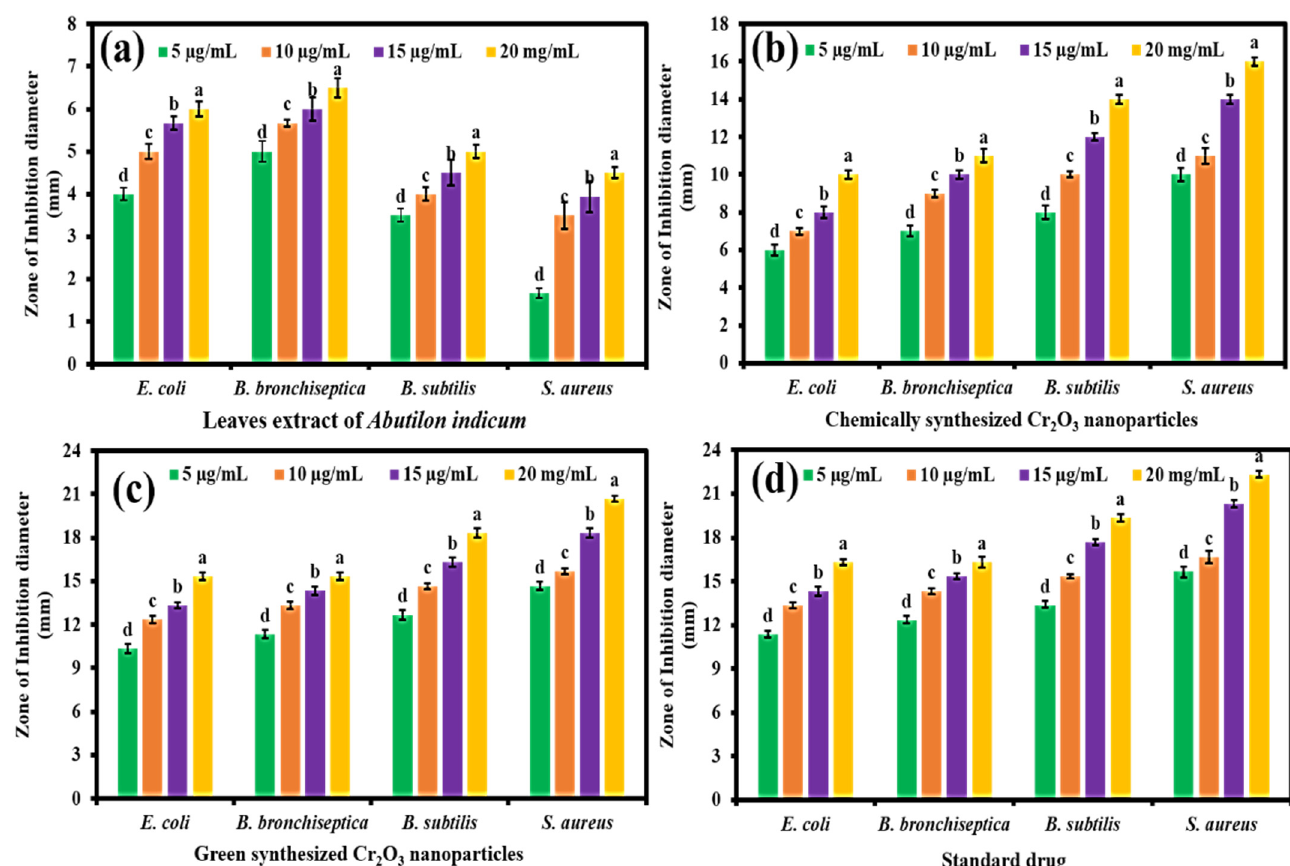
Figure 4. The antibacterial activity of ( a ) Abutilon indicum (L.) Sweet leaf extract, ( b ) chemically synthesized Cr 2 O 3 nanoparticles, ( c ) green synthesized Cr 2 O 3 nanoparticles in terms of zones of inhibition (ZOIs) at different concentration levels against different bacteria compared to standard drug ( d ). (Note: Tukey based heterogeneous lower-case letters represent significant pairs).